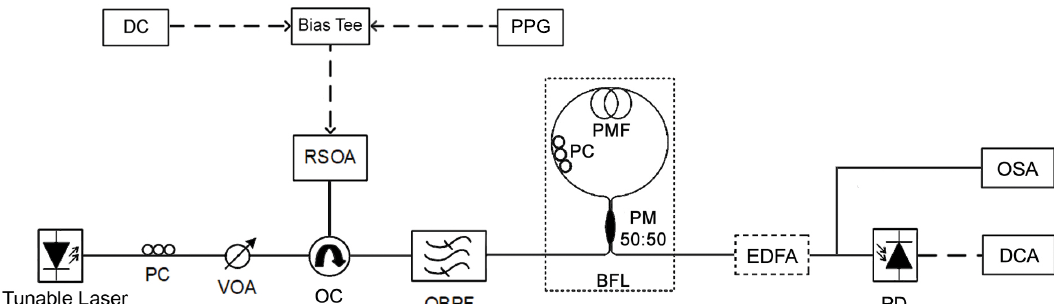
Figure 6. Experimental setup of RSOA electrical modulation. RSOA: reflective semiconductor optical amplifier, BFL: birefringent fiber loop, PPG: pulse pattern generator, OC: optical circulator, OBPF: optical bandpass filter, VOA: variable optical attenuator, PM 50:50: 3 dB polarization maintaining coupler, PMF: polarization maintaining fiber, PC: polarization controller, EDFA: erbium doped fiber amplifier, PD: photodiode, DCA: digital communications analyzer, OSA: optical spectrum analyzer. Solid and dashed lines show optical and electrical paths,